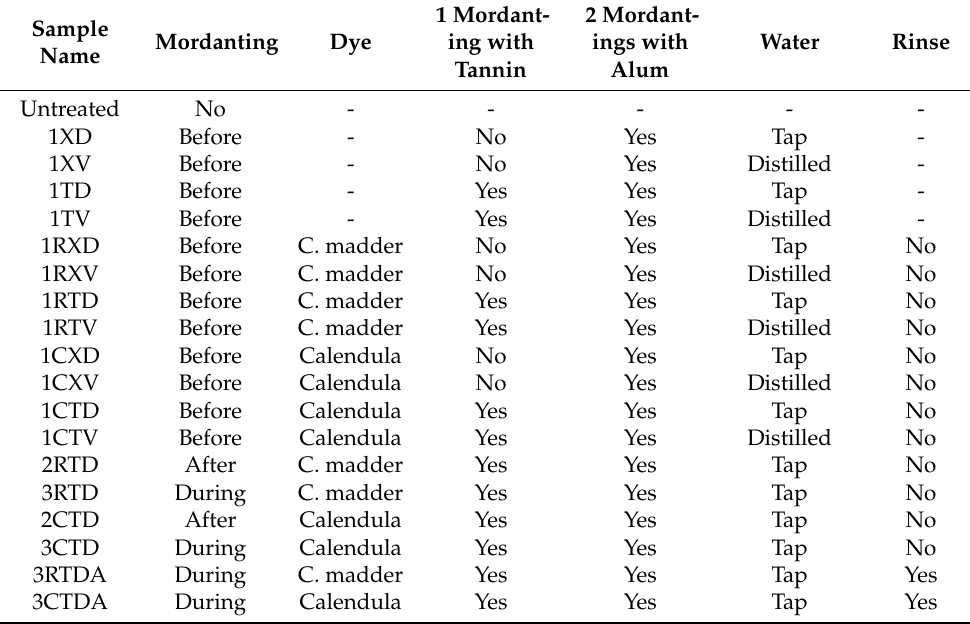
Figure 2. Procedure for the application of natural dyes on hemp/cotton fabrics. Table 1. Nomenclature of the samples according to the process